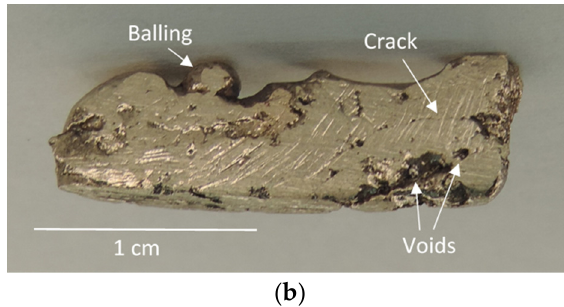
Figure 6. Experimental examples of scanning LMH–AM products: ( a ) An L-shape metal rod fabri- cated by two straight rods, each produced by scanning LMH–AM and joined together by a powder- batch LMH. ( b ) A metal object (~ 20 4 6 × × mm 3 ) made of 5 powder layers by scanning LMH–AM